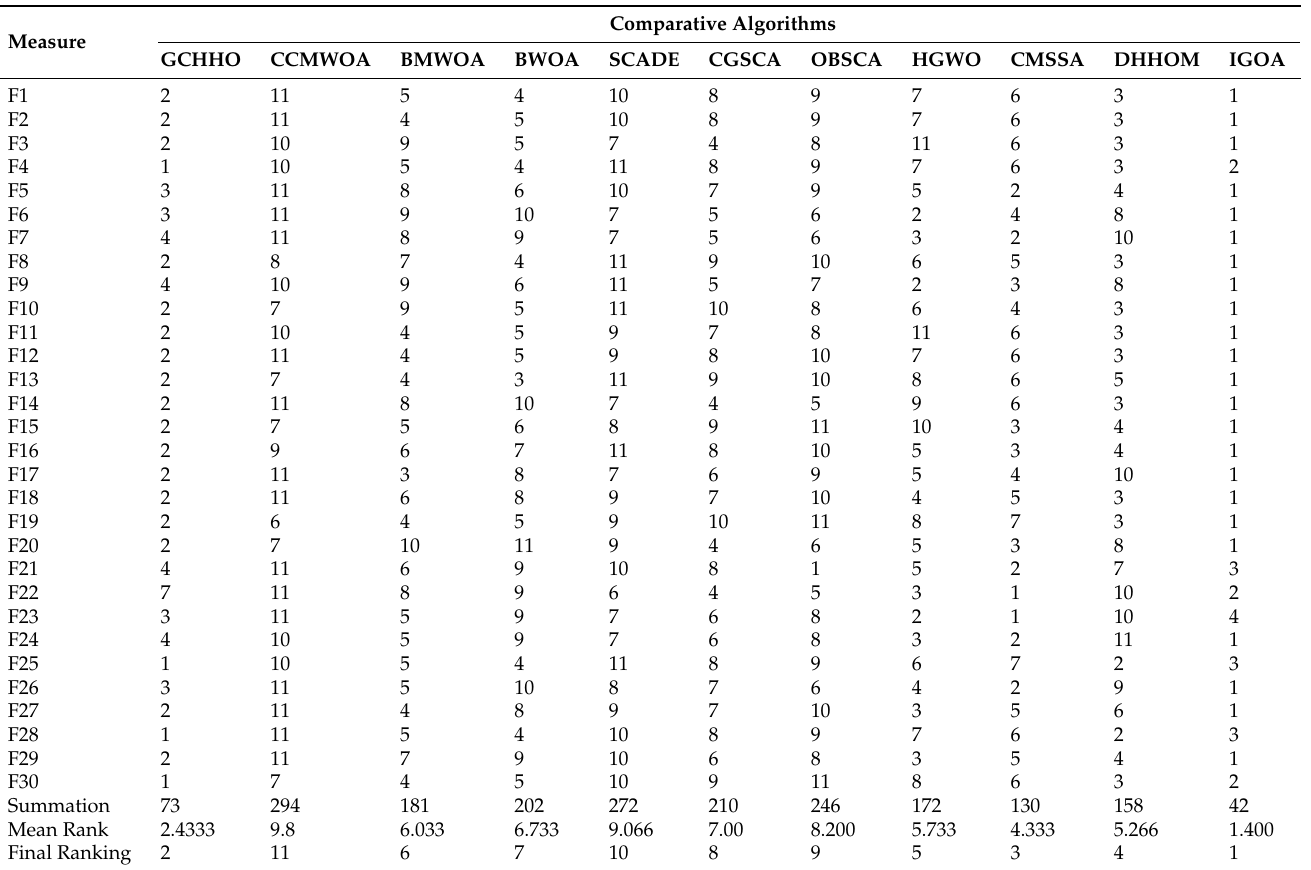
Table 11. The results of the Friedman ranking test of the comparative methods using 30 CEC2017 benchmark